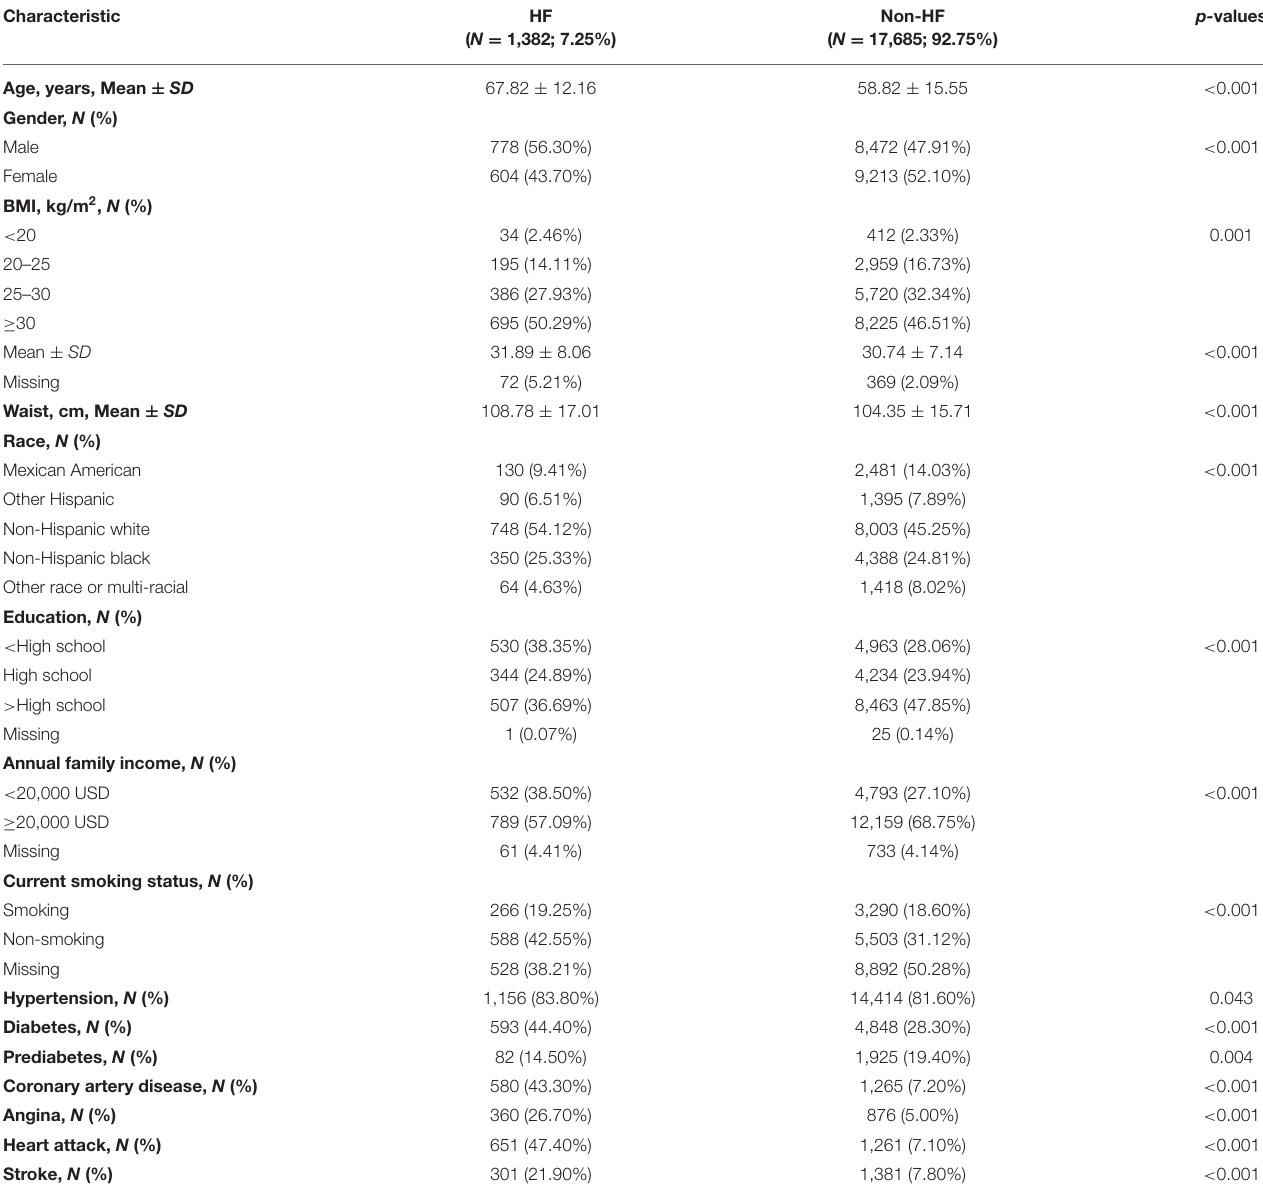
TABLE 1 | Demographics and characteristics of participants, from NHANES 1999–2018.